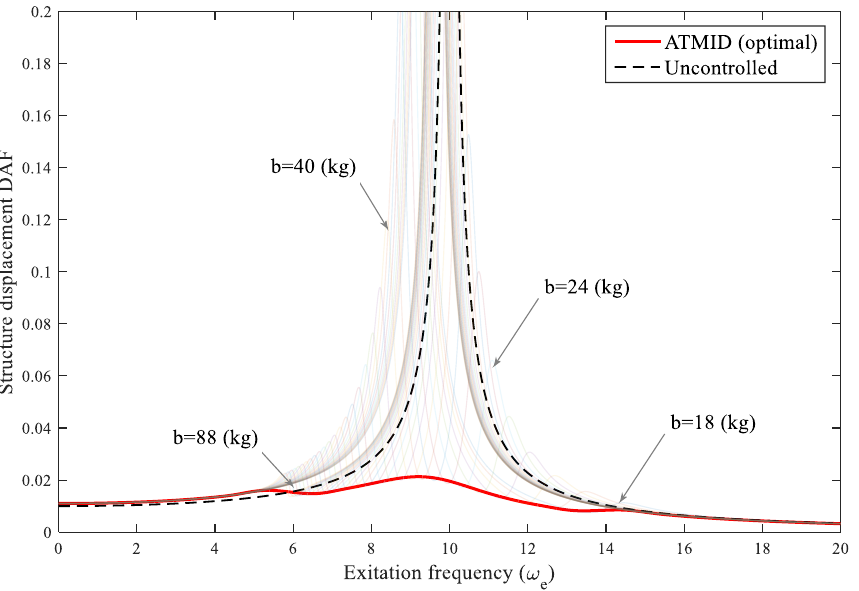
Figure 6. The FRC of the adaptive controlled and uncontrolled SDOF structures.